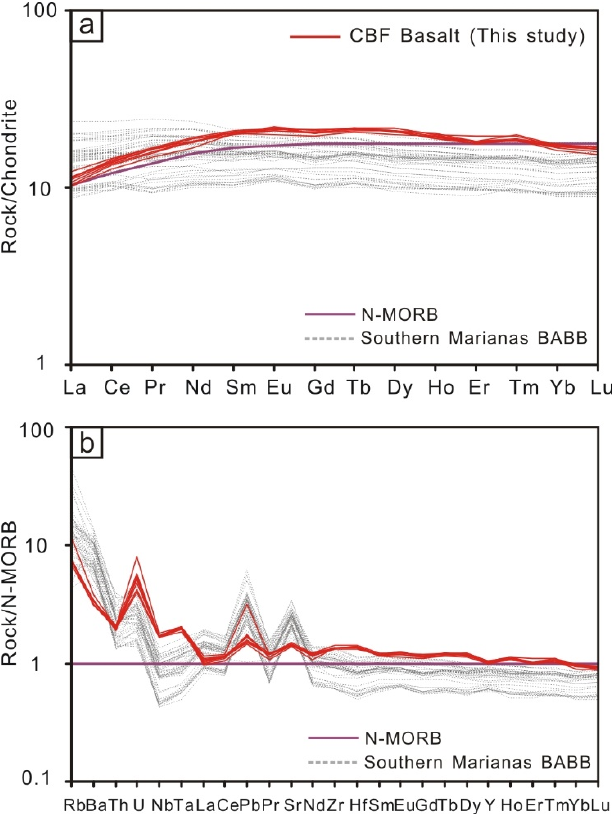
Figure 4. ( a ) Chondrite-normalized lanthanide profiles and ( b ) N-MORB-normalized trace element profiles for basalts from CBF in the WPB. The chondrite- and N-MORB-normalizing data are from Reference [27]. Data for the Southern Mariana back-arc basin are from Reference [28].